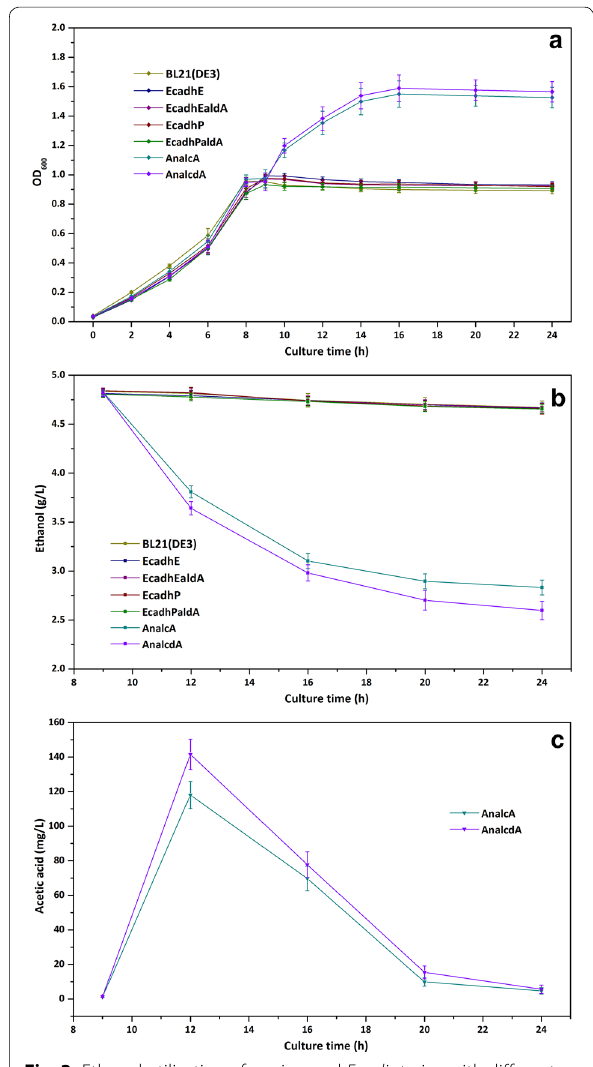
Fig. 3 Ethanol utilization of engineered E. coli strains with different alcohol/aldehyde dehydrogenases. a Growth curves of engineered strains harboring different alcohol/aldehyde dehydrogenases; b residual ethanol concentrations of different engineered strains; c acetic acid concentrations of strains BL21/pTrc-AnalcA and BL21/ pTrc-AnalcdA during the fermentation